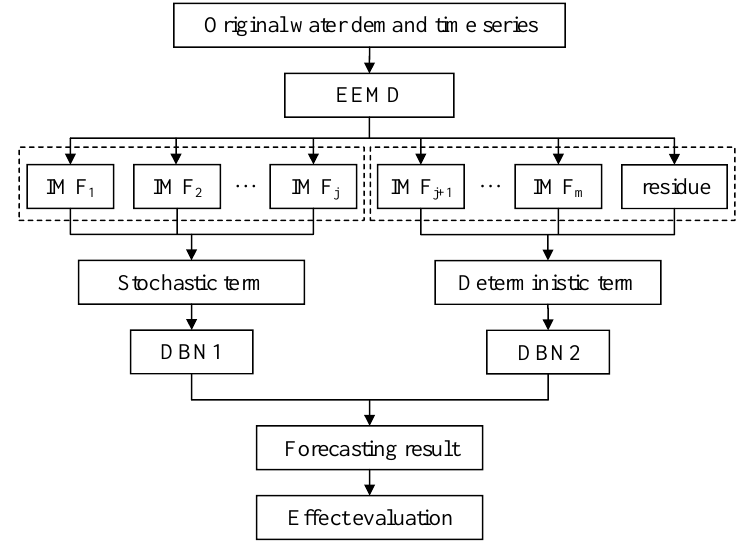
Figure 2. Modeling structure flow chart of the DSDBN model.